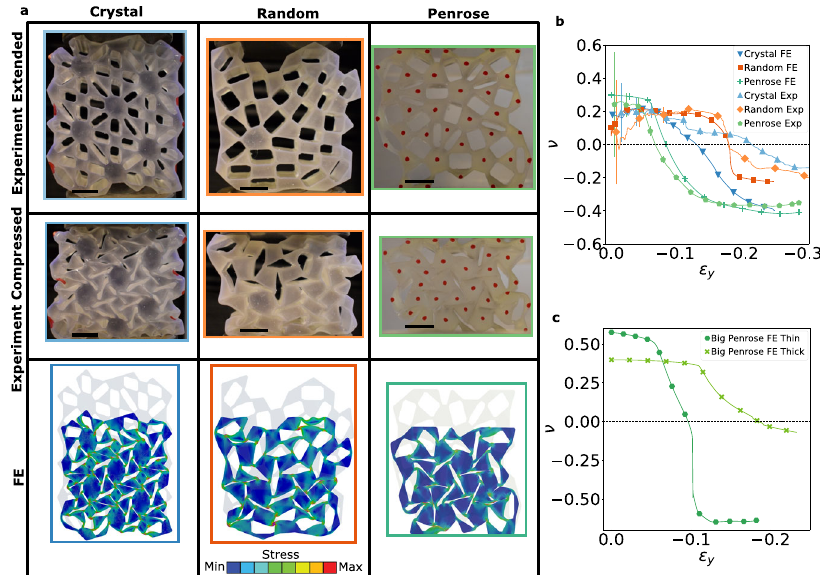
Fig. 1 Auxetic behaviour on demand. a Shows the uniaxial compression test of three auxetic designs, each of them generated with our proposed algorithm. More on Supplementary Movie 1 and 2. Scale bars 1 cm. The colormap on the fi nite element simulations shows the sections of minimum and maximum stress in the elastic material. Clearly the stress is focused on the joints between polygons. b The Poisson ’ s ratio of each con fi guration as a function of the strain. “ Exp ” and “ FE ” refer to experimental and fi nite element simulations results respectively. The experimental error bars show the standard deviation from measuring each polygon ’ s position. c Comparison between two bigger Penrose structures with thin and thick bonds, showing the capabilities of tuning the Poisson ’ s ratio as a function of the bending energy. These bigger structures can be found on Supplementary Note 3. More information on the experimental and fi nite element simulations set-ups on Methods: “ Experimental Setup ” and “ Finite Element Simulations ”